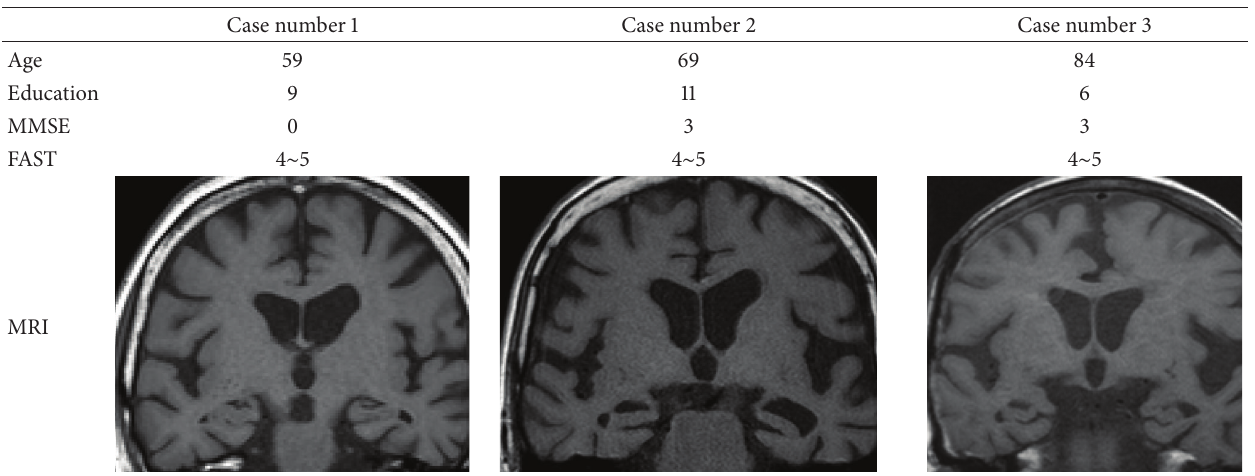
Table 1: Clinical characteristics of three SD cases.